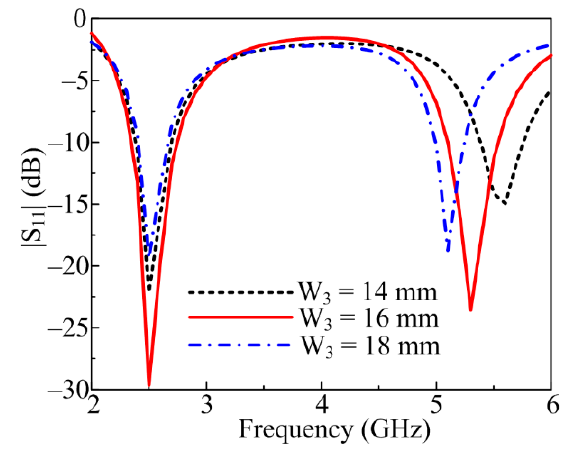
Figure 3. Parametric analysis of proposed antenna by varying lower stub (W 3 ).